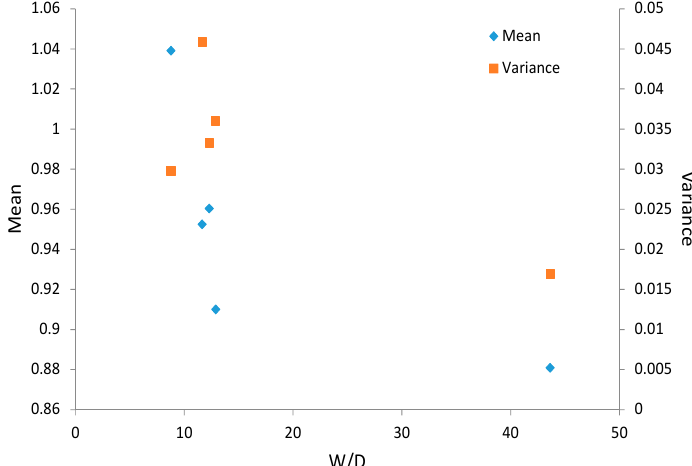
Figure 3. Mean and variance of the velocity index, k , for the selected gage sites as a function of the aspect ratio (W/D).